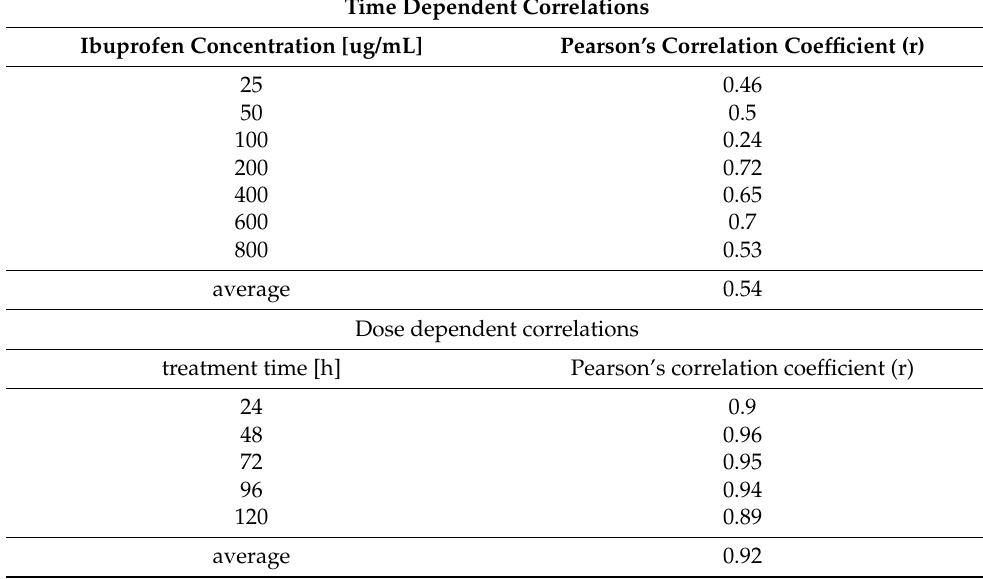
Table 1. Pearson’s correlation analysis was performed to check whether there was a linear relation between cell viability and the ibuprofen dose or treatment time. The effect of ibuprofen on hBM-MSCs viability was evaluated with MTT assay. Cells from 6 donors were treated with different concentra- tions of ibuprofen (25 µ g/mL, 50 µ g/mL, 100 µ g/mL, 200 µ g/mL, 400 µ g/mL, and 800 µ g/mL) for, respectively, 24 h, 48 h, 72 h, 96 h or 120 h. The experiment was performed in triplicates. Time Dependent Correlations Ibuprofen Concentration